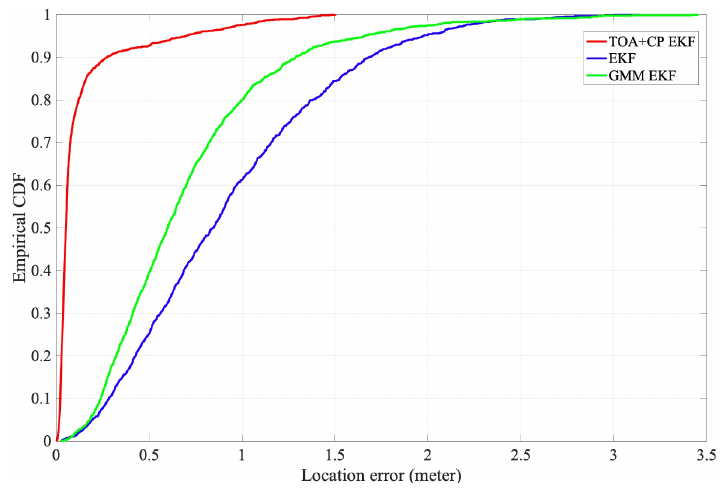
Figure 8. The CDF of horizontal localization